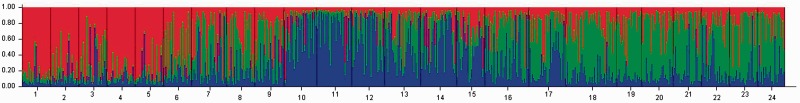
The STRUCTURE assignment of each individual to inferred genetic clusters (marked in different colours). The study populations are separated by thick black lines. Population numbers (1–24) are listed in Table 1 and Supporting Information—Table S1.